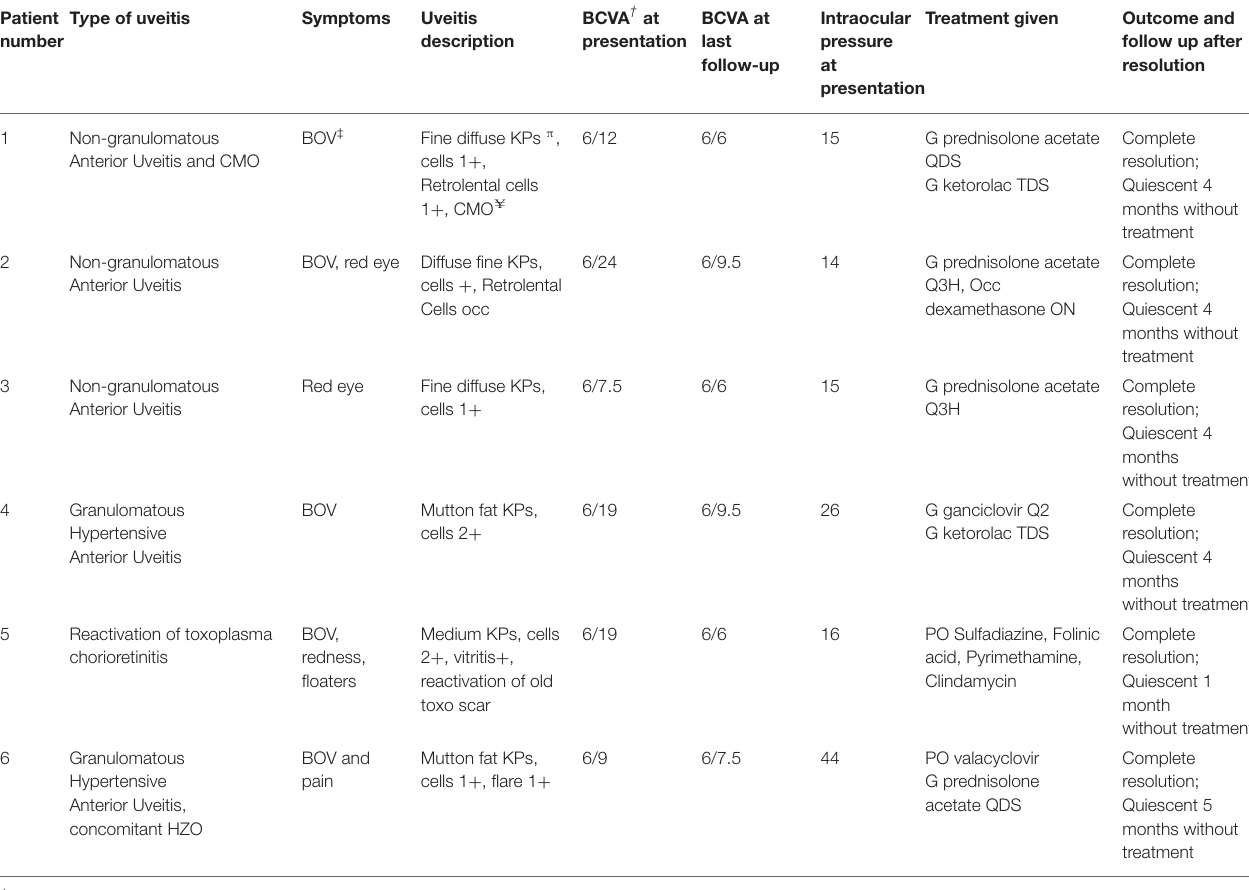
TABLE 2 | Patient clinical findings, treatment and outcome of COVID-19 associated uveitis. Patient T y pe of uveitis Symptoms Uveitis number